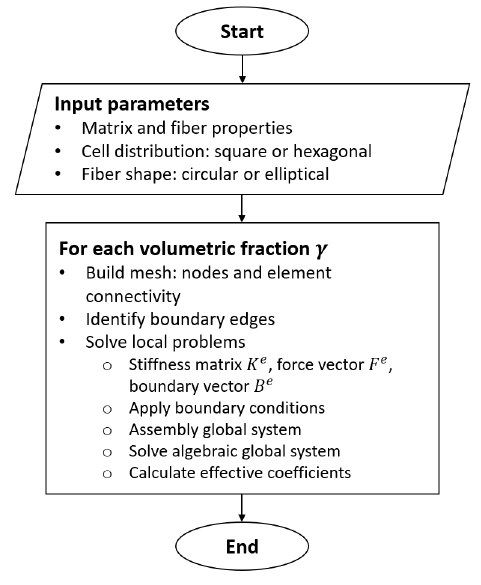
Figure 13. Computational implementation